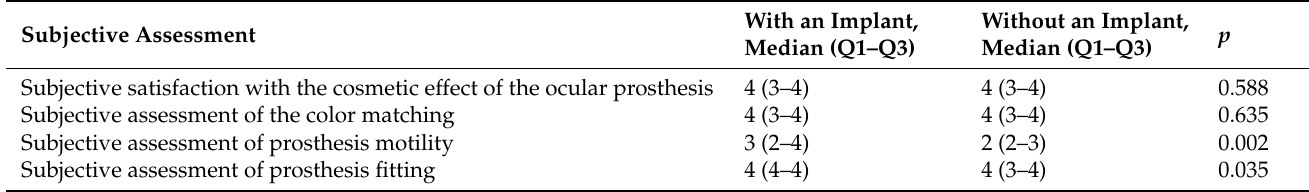
Table 2. Comparison of subjective assessment score between patients with and without an orbital